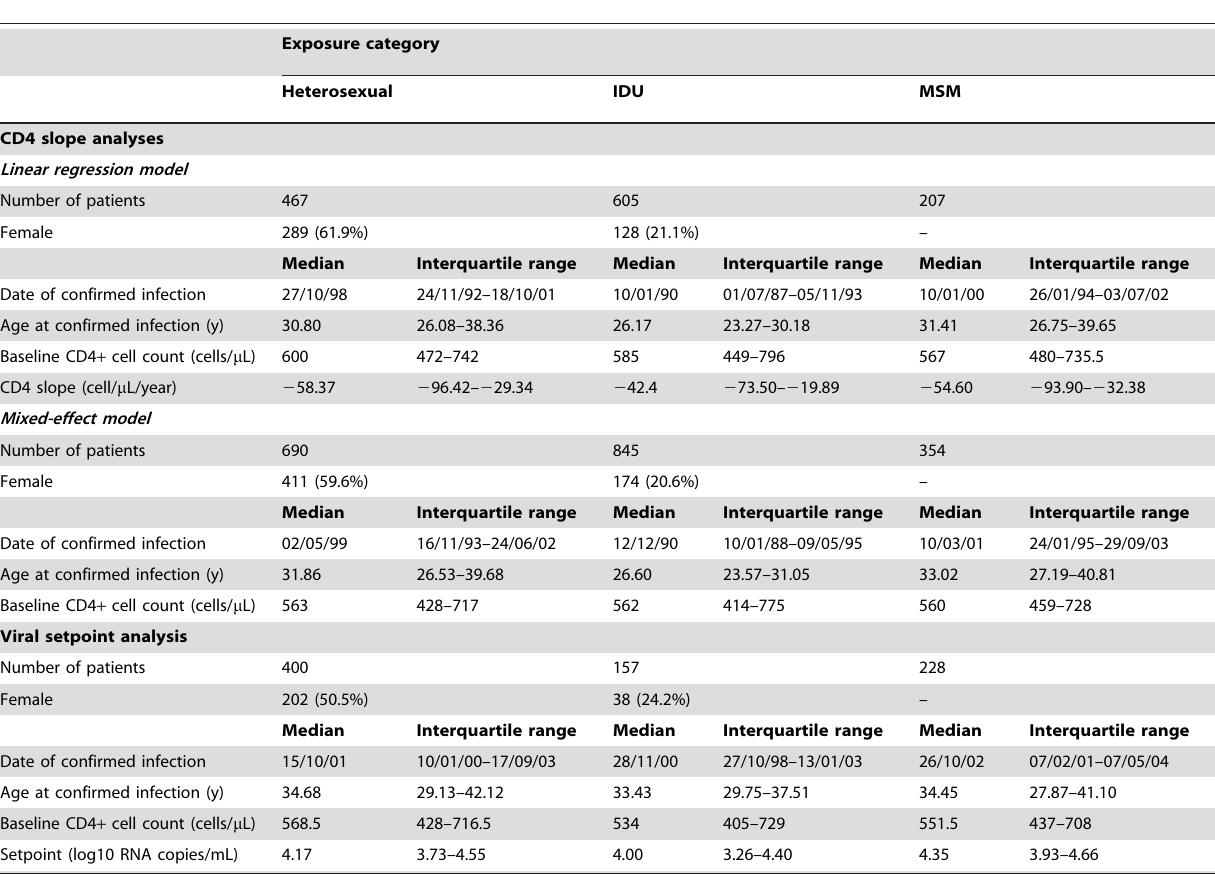
Table 1. Demographic and clinical characteristics of the study groups included in the various